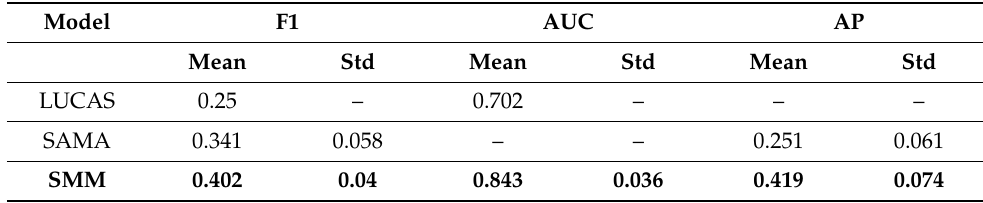
Table 8. Descriptive statistics of